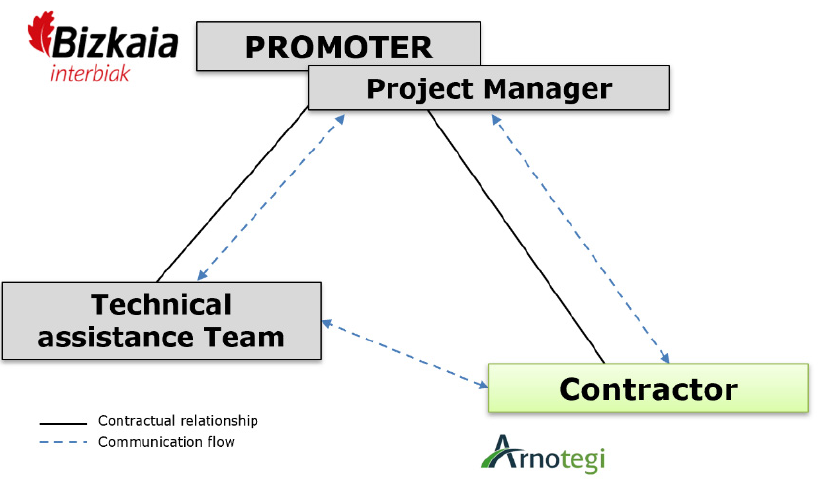
Figure 4. Diagram of the main participants in the execution of the Arnotegi tunnel. Contractual links shown.